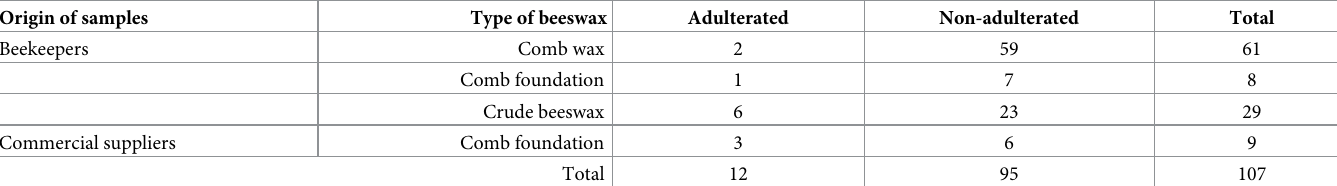
Table 1. Contingency table of results for adulteration of beeswax.